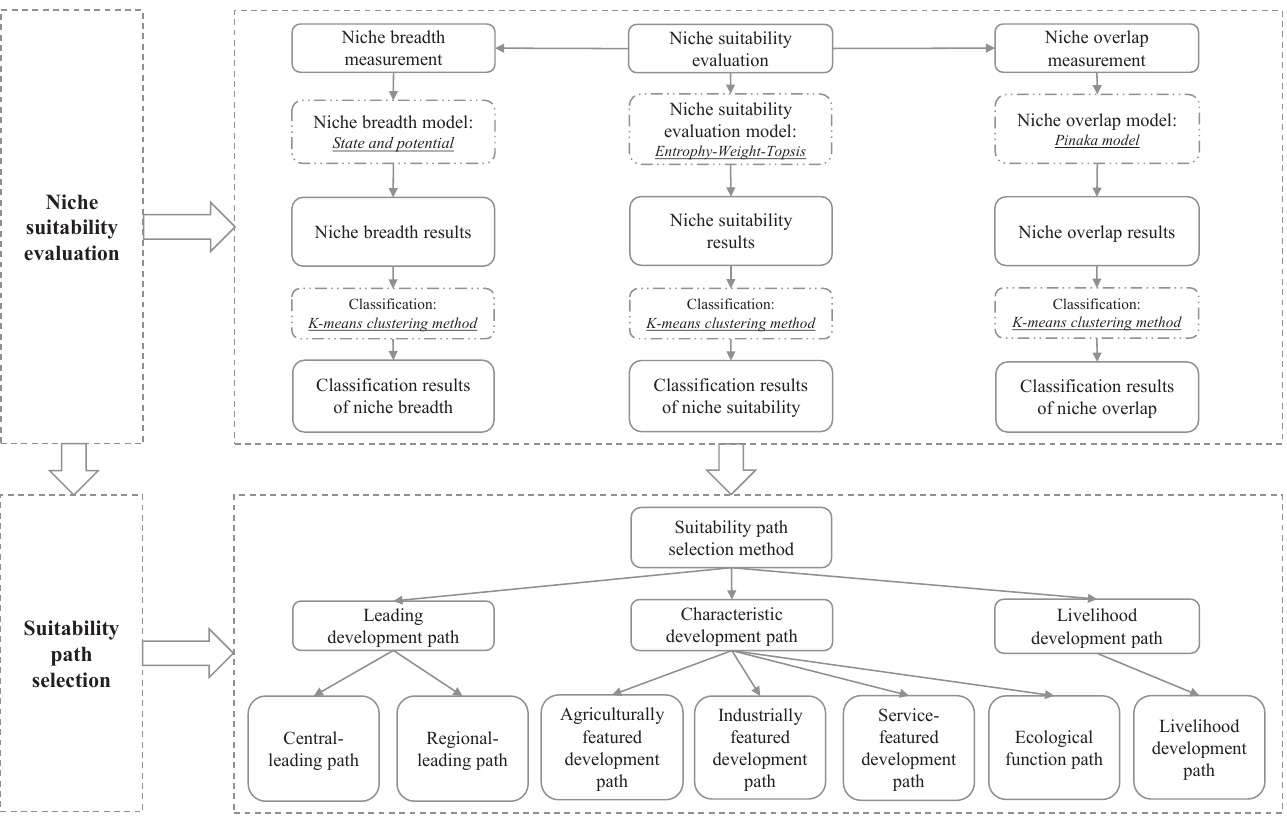
Figure 2. Flowchart of the study